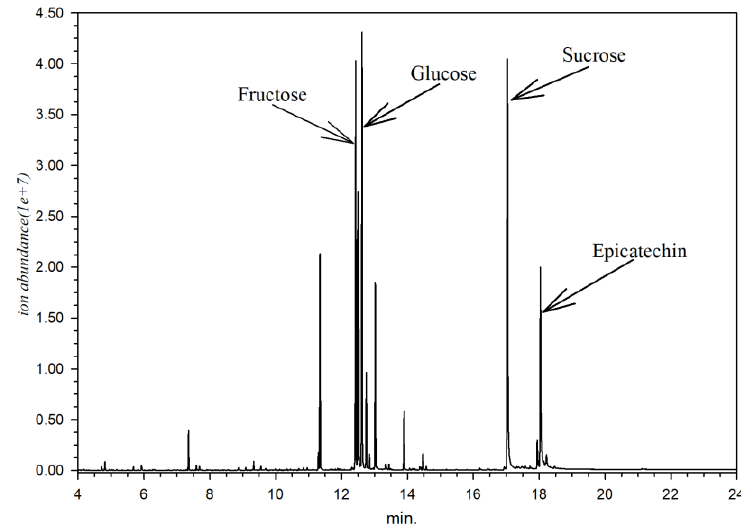
Figure 1. Chromatogram of X. granatum stem extract according to GC-MS analysis.